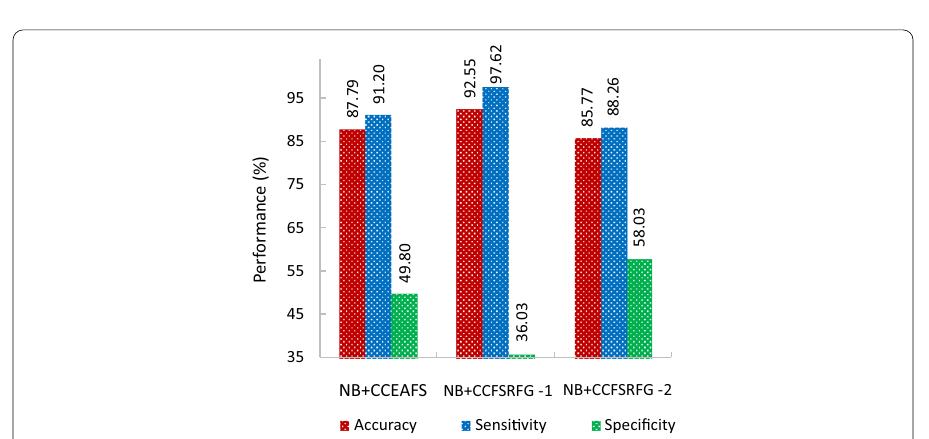
Fig. 11 Performance evaluation of the NB classifier on the QSAR Oral Toxicity